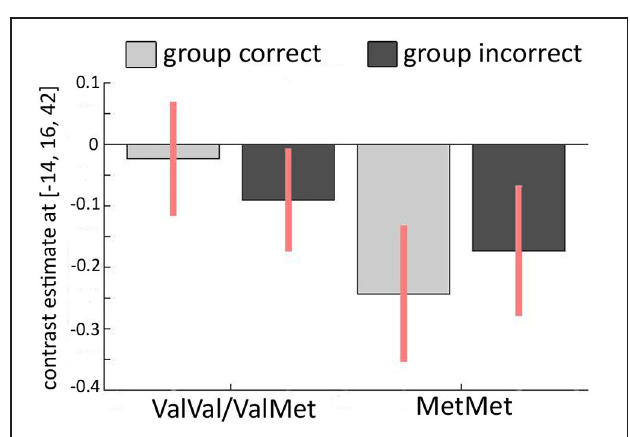
FIGURE 4 | Relationship between COMT Val158Met and imaging results. Interaction of incorrect vs. correct group response and COMT polymorphism in the left ACC (MNI − 14/16/42). The activation pattern for carriers of at least one Val-allele (Val + ) is different from the pattern found in homozygous Met-allele carriers (Val − ) across the two conditions in which the majority of the group is either correct or incorrect, revealing a significant interaction between genotype and brain